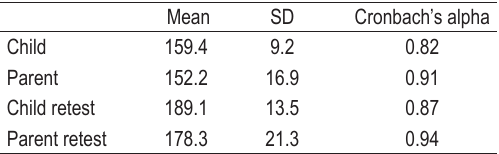
TABLE 3. Cronbach’s alpha values and means (standard deviations [SDs]) for ACHS-C and